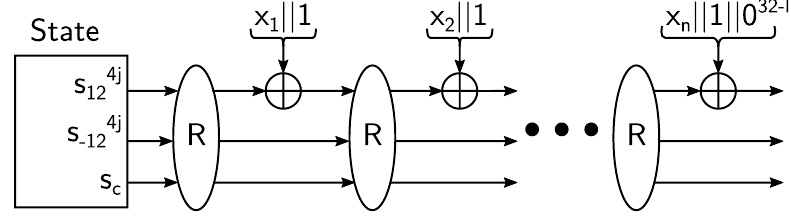
Figure 6: Subterranean absorb with operation keyed.